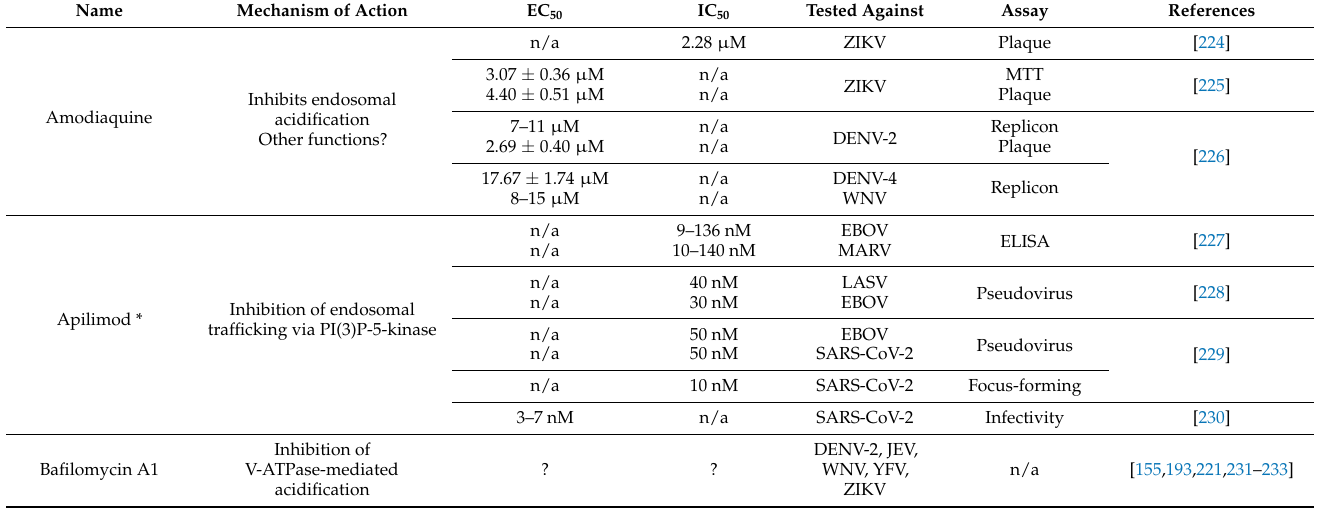
Table 1. Summary table highlighting antivirals that target or may target viral endocytosis. EC 50 and IC 50 correspond to the half-maximal effective and inhibitory concentrations, respectively. Each EC 50 or IC 50 value is associated with a specific virus, assay, and